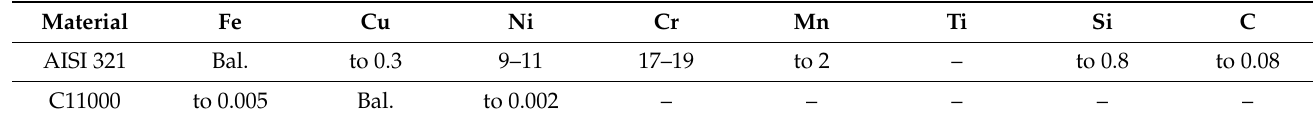
Table 1. Chemical composition of copper and steel wires.